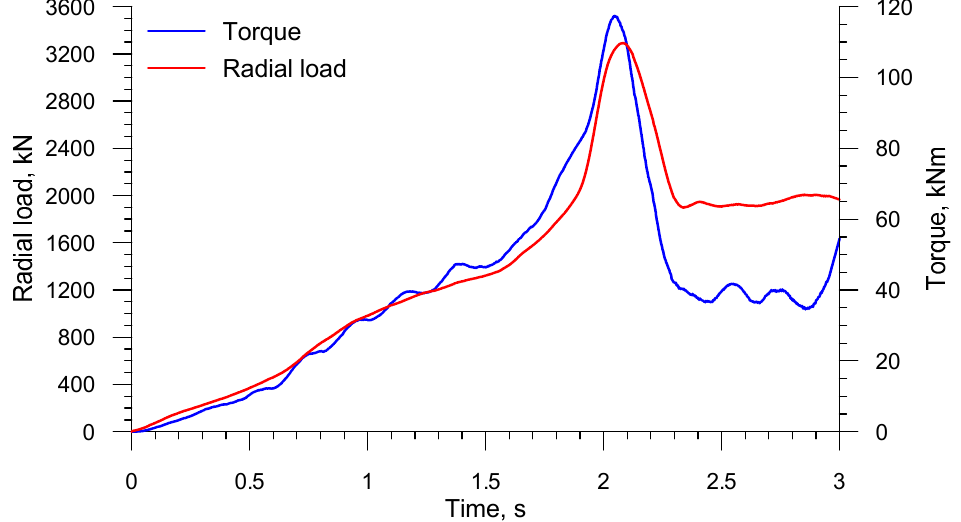
Figure 23. Force parameters acting on the tools during calibration of a hollow axle produced in a 3-roll mill.